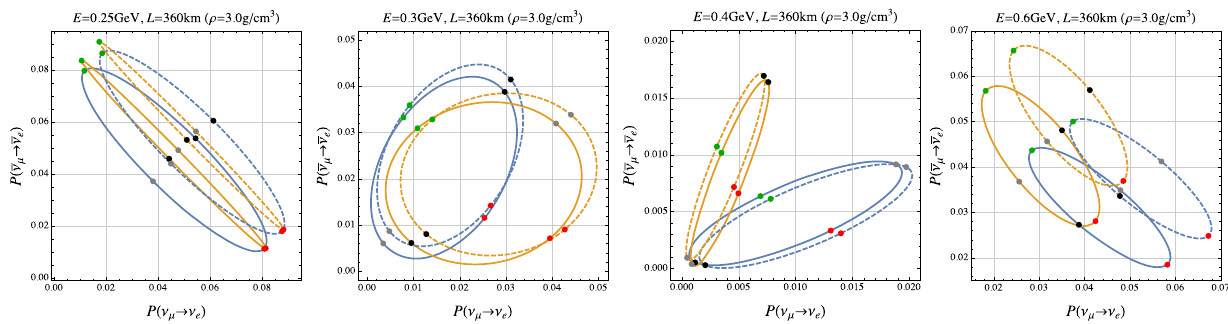
Fig. 3 Bi-probability plots for L = 360 km (ESS-Zinkgruvan). In this energy range E = 250–600 MeV, the oscillation probabilities